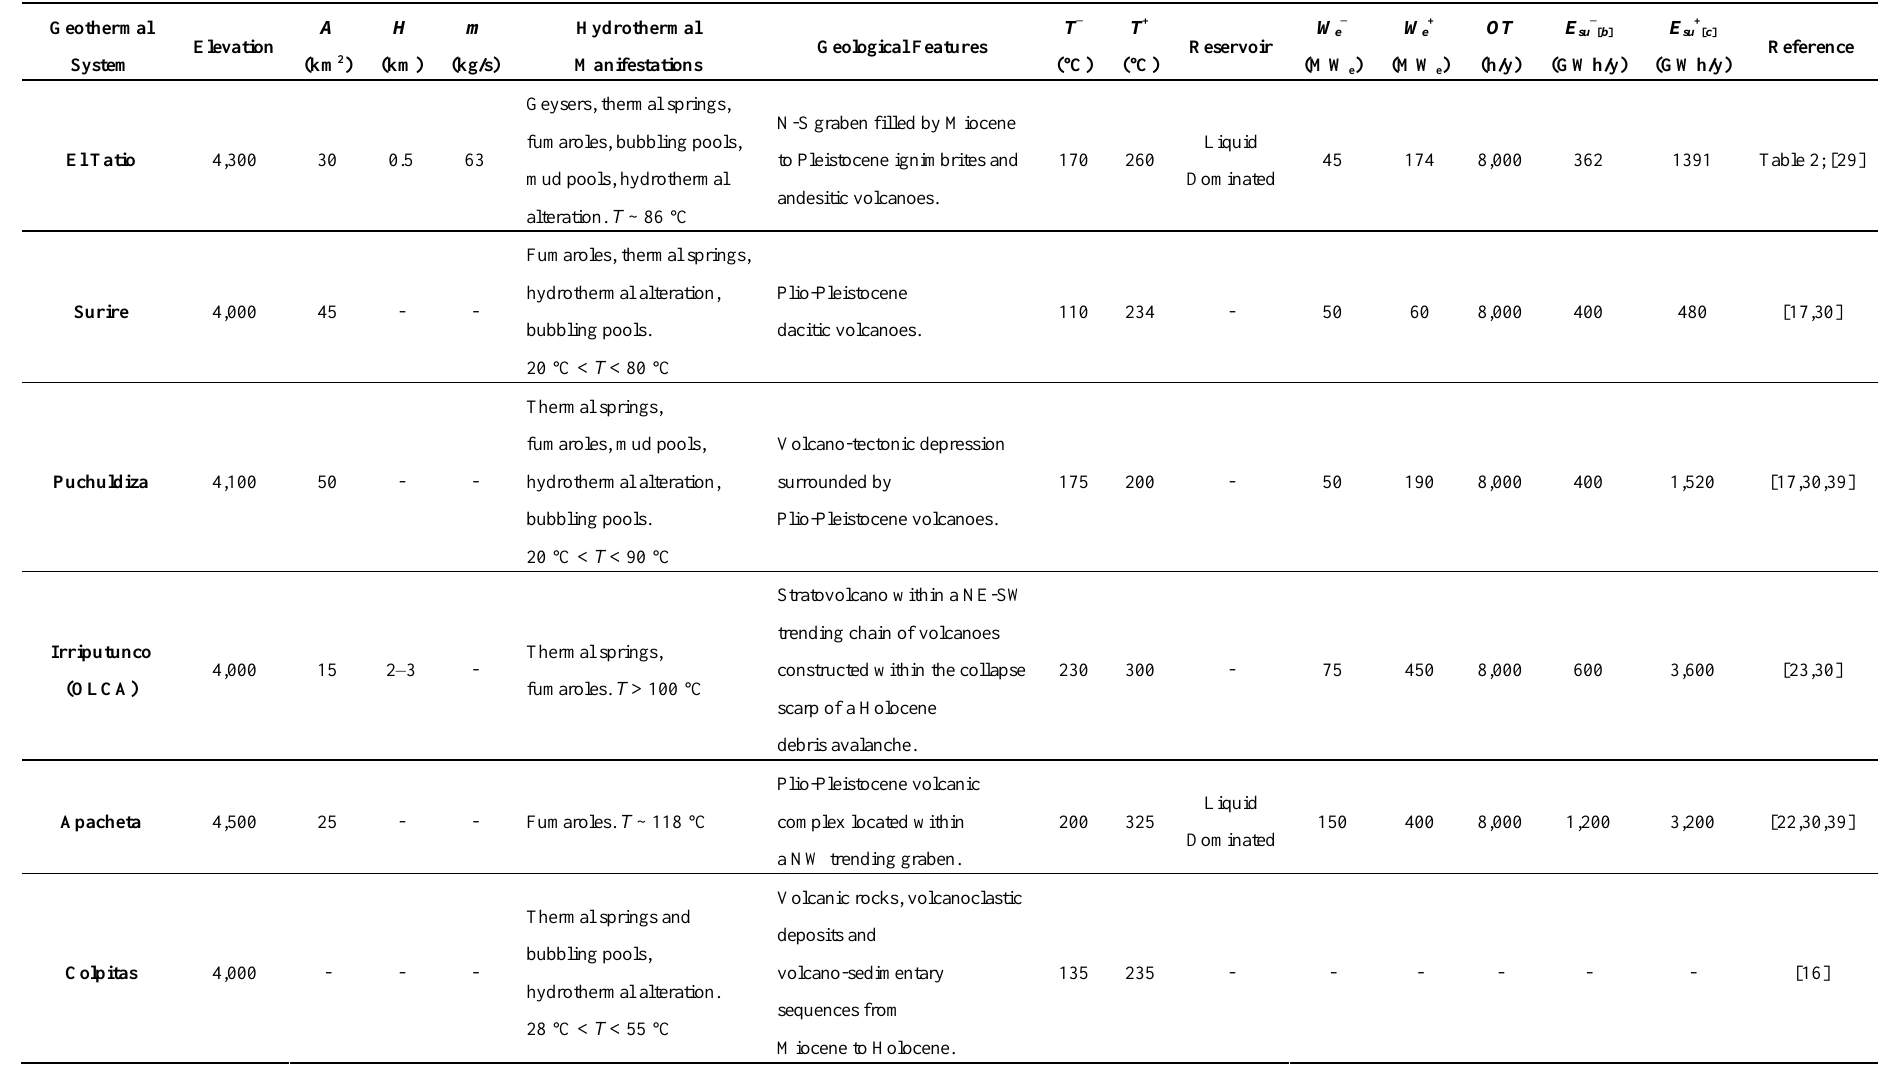
Table 4. Evaluations of the thermal and electric power for the northern